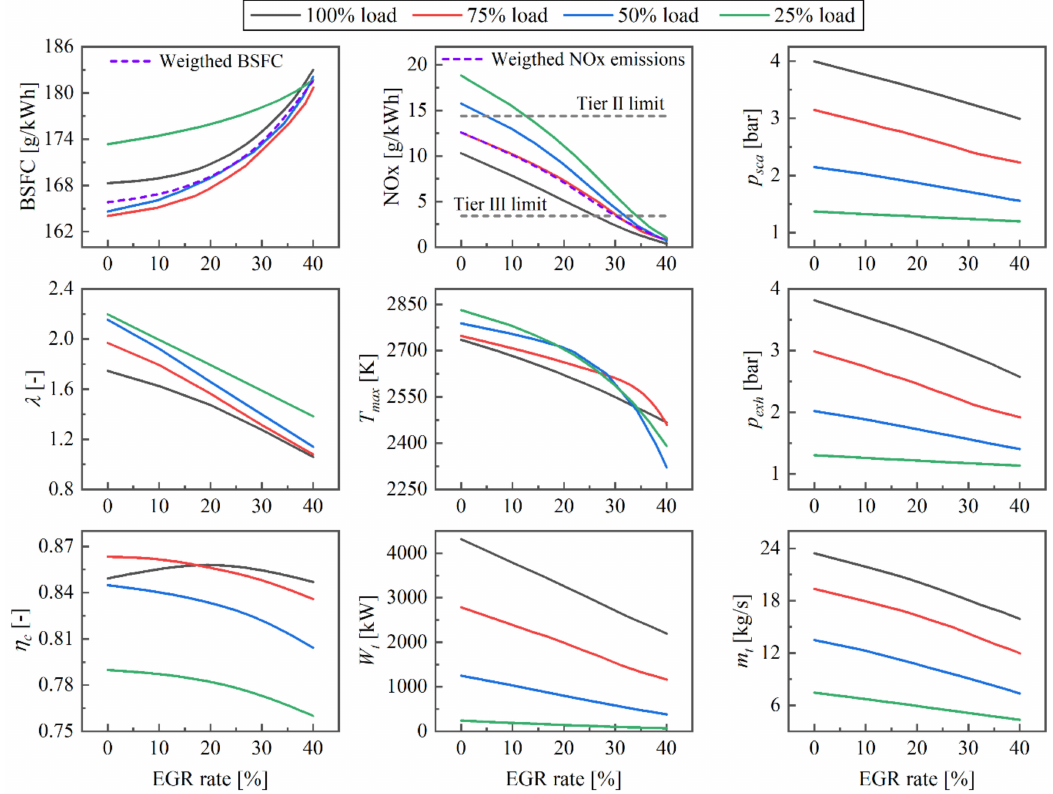
Figure 6. Effects of BL-EGR engine configuration setting on performance and NOx emissions ( λ , trapped air–fuel ratio; T max , peak temperature of burned zone; η c , compressor efficiency; W t , turbine power; m t , exhaust gas mass flow rate of